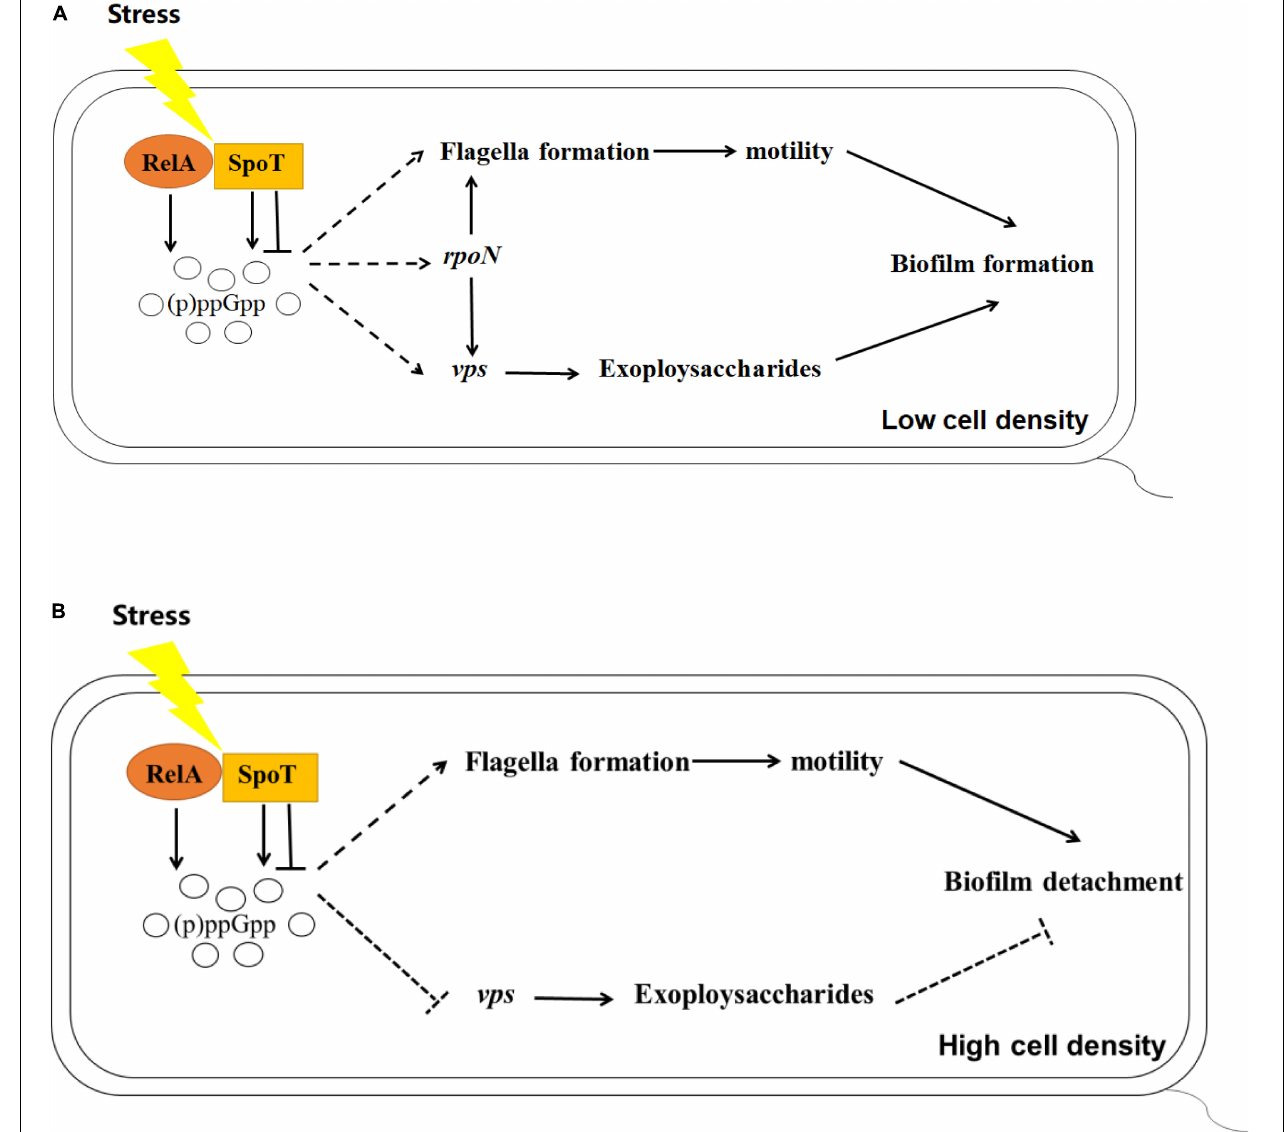
FIGURE 8 | Schematics outlining the putative regulation of biofilm mediated by (p)ppGpp in V. alginolyticus at low (A) or high (B) cell density, respectively. Pathways have been mentioned by previous reports are depicted with the solid lines, while the inferences of this study are represented with the dashed lines. Arrows indicate promotion and horizontal symbols mean